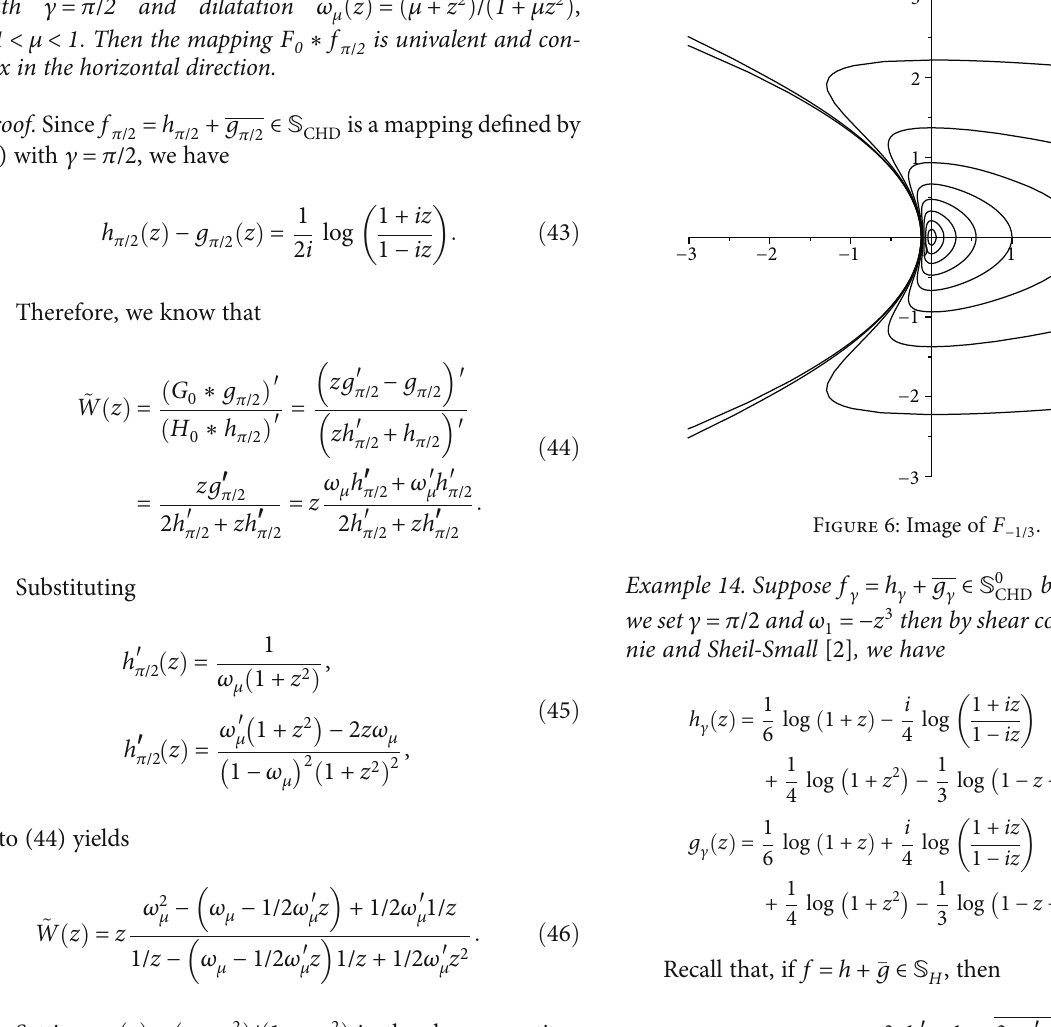
Figure 5: Image of f